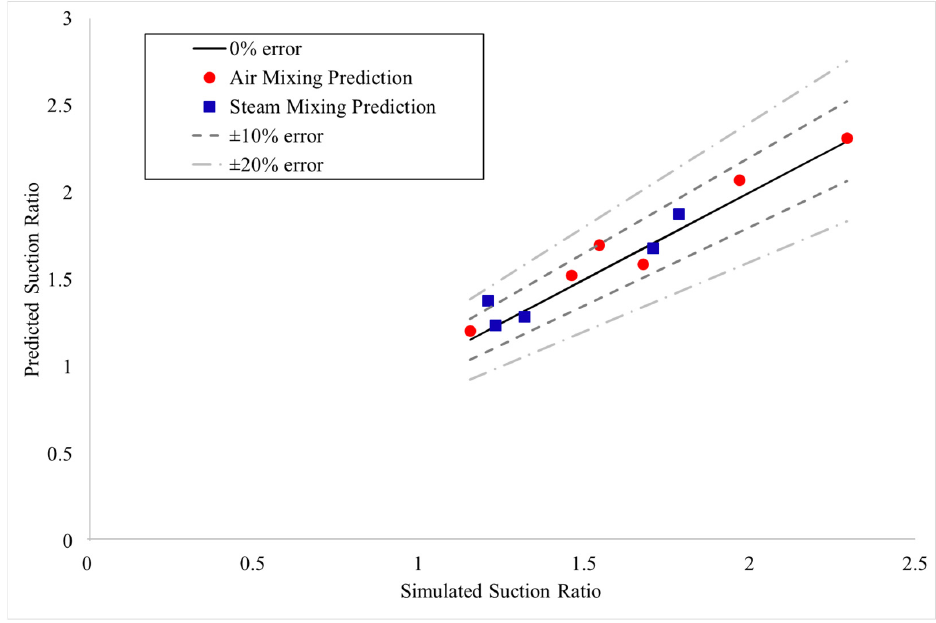
Figure 11. Suction ratio predicted by the high suction ratio correlation vs. the suction ratio from the validated simulation.